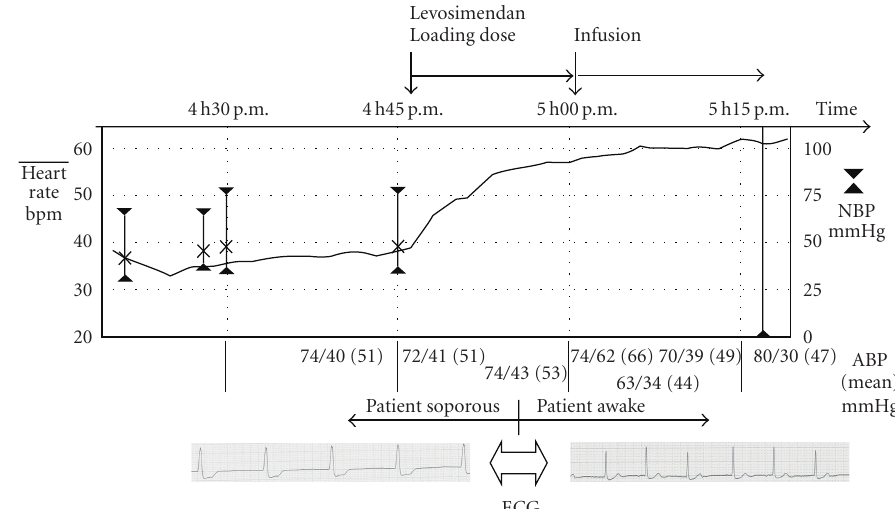
Figure 1: Vital signs in relation to levosimendan application. ABP: arterial blood pressure; NBP: non-invasive blood pressure.